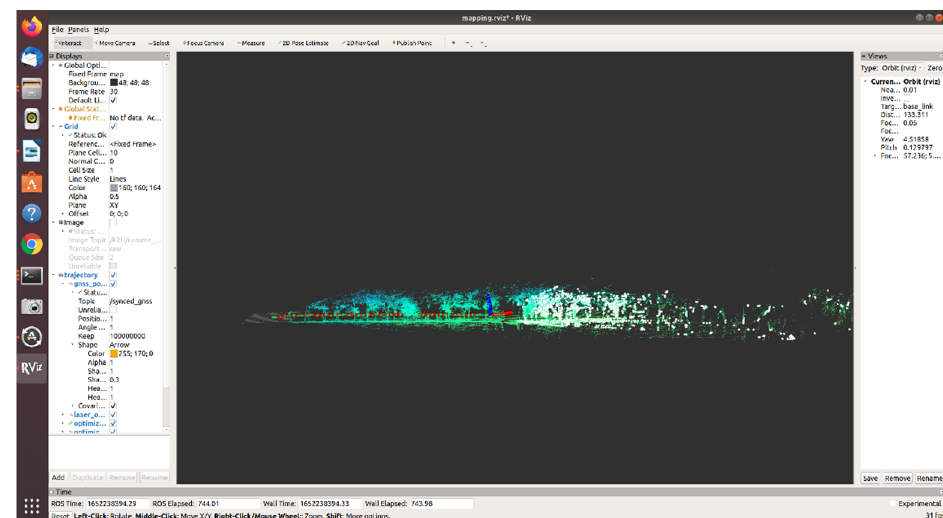
Figure 11. 3D reconstruction of LOAM-Livox algorithm.